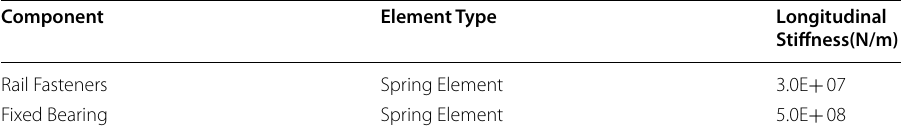
Table 2 Stiffness of Spring Elements